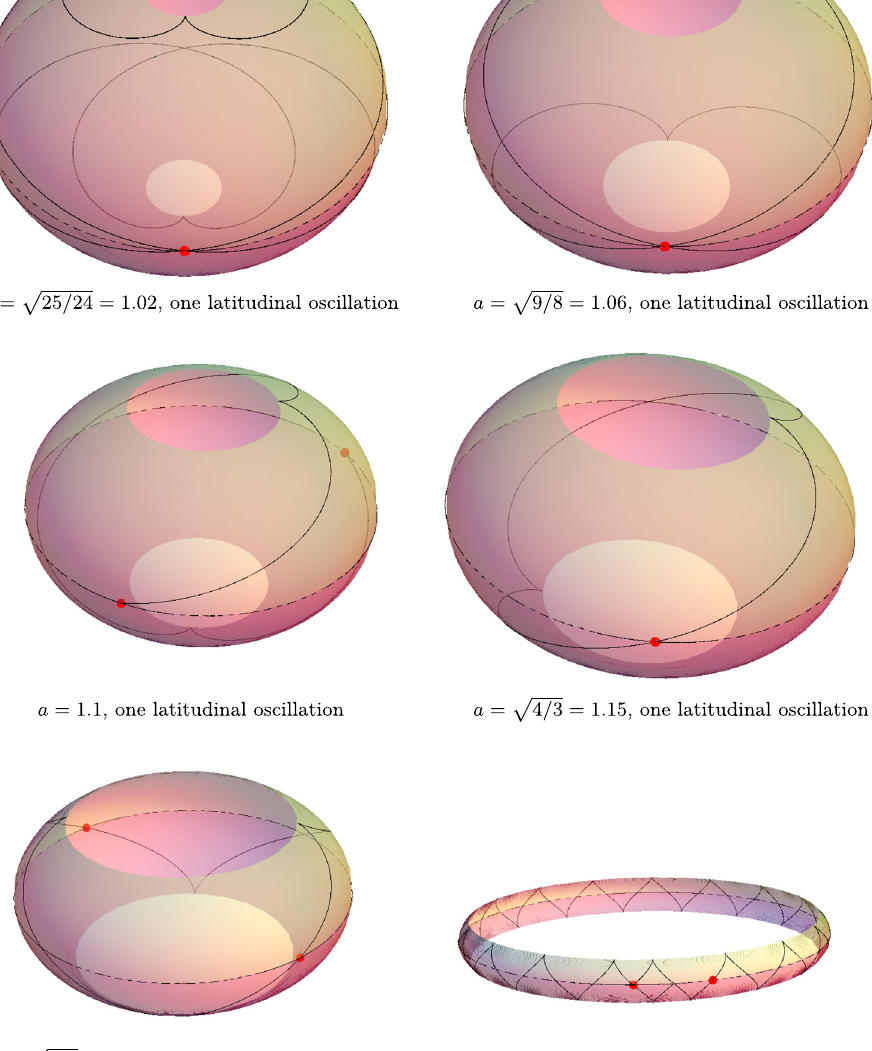
Fig. 13 The SPOs with zero energy, located solely at radius r = 1, are presented for KNS spacetimes with increasing value of the rotational parameter a . The turning points of the latitudinal and the azimuthal motion coalesce in these cases, hence the turning loops have shrinked into peaks. In the attached Table 2 we demonstrate the descending total change in azimuth per one latitudinal oscillation, and the descending range in the latitudinal motion, with increasing spin parameter a . In some cases closed spherical orbits emerge due to properly chosen parameters of the SPOs